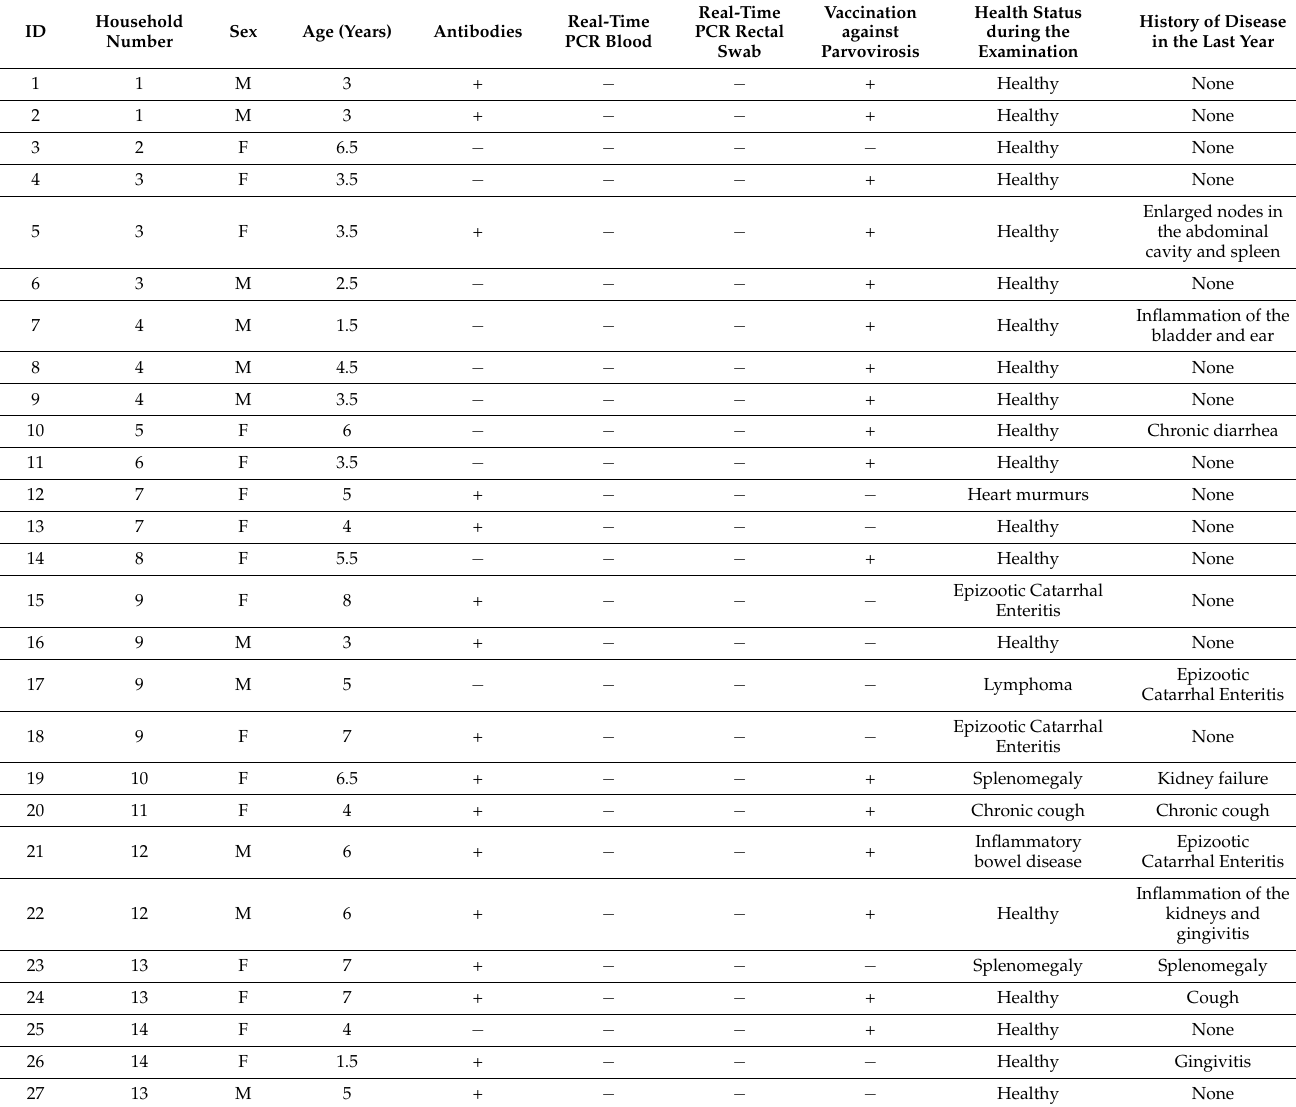
Table 1. Health condition of ferrets on the day of examination and results of PCR and antibody tests for Aleutian disease in ferrets ( n = 61) from two provinces in